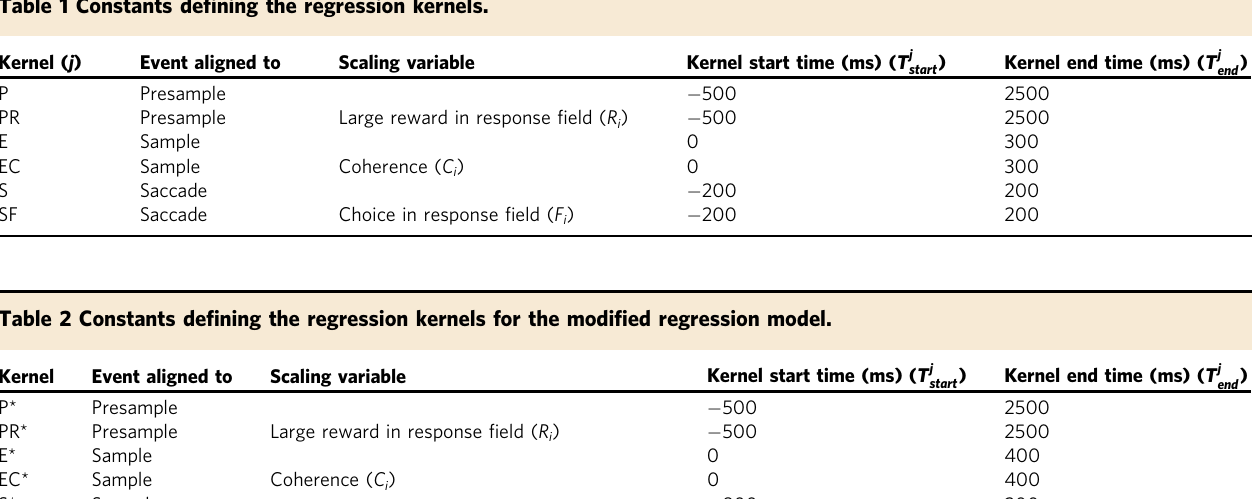
Table 1 Constants de fi ning the regression kernels.